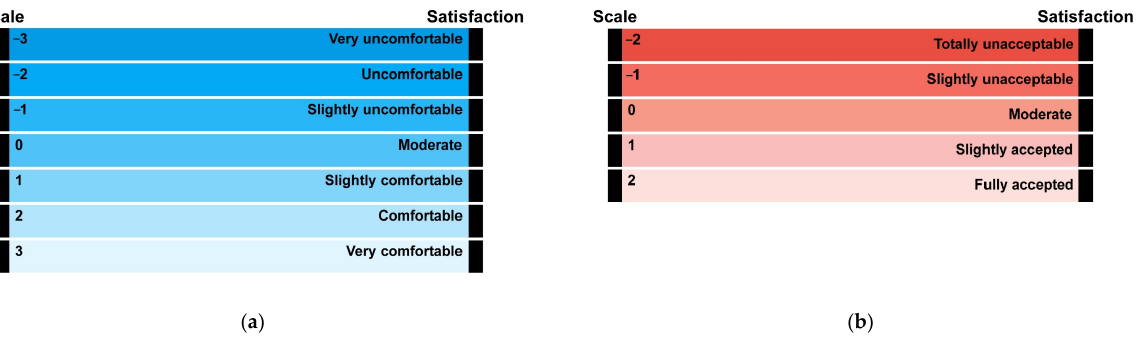
Figure 4. Subjective heat sensation voting scale; ( a ) is the Thermal comfort voting scale; ( b ) is the Thermal sensory voting scale. Table 2. Summary of the data used to calculate PET values.